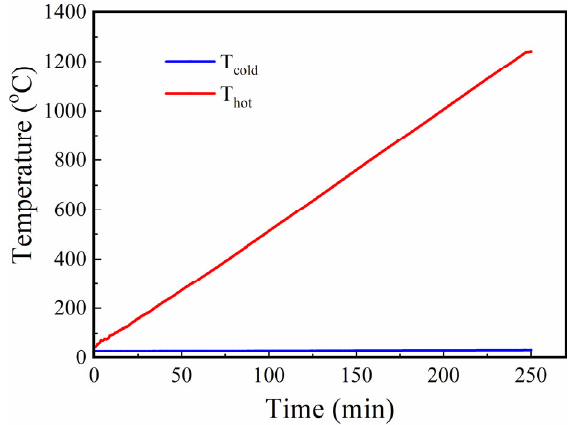
Figure 3. Temperature change curve of thermocouple cold and hot ends.